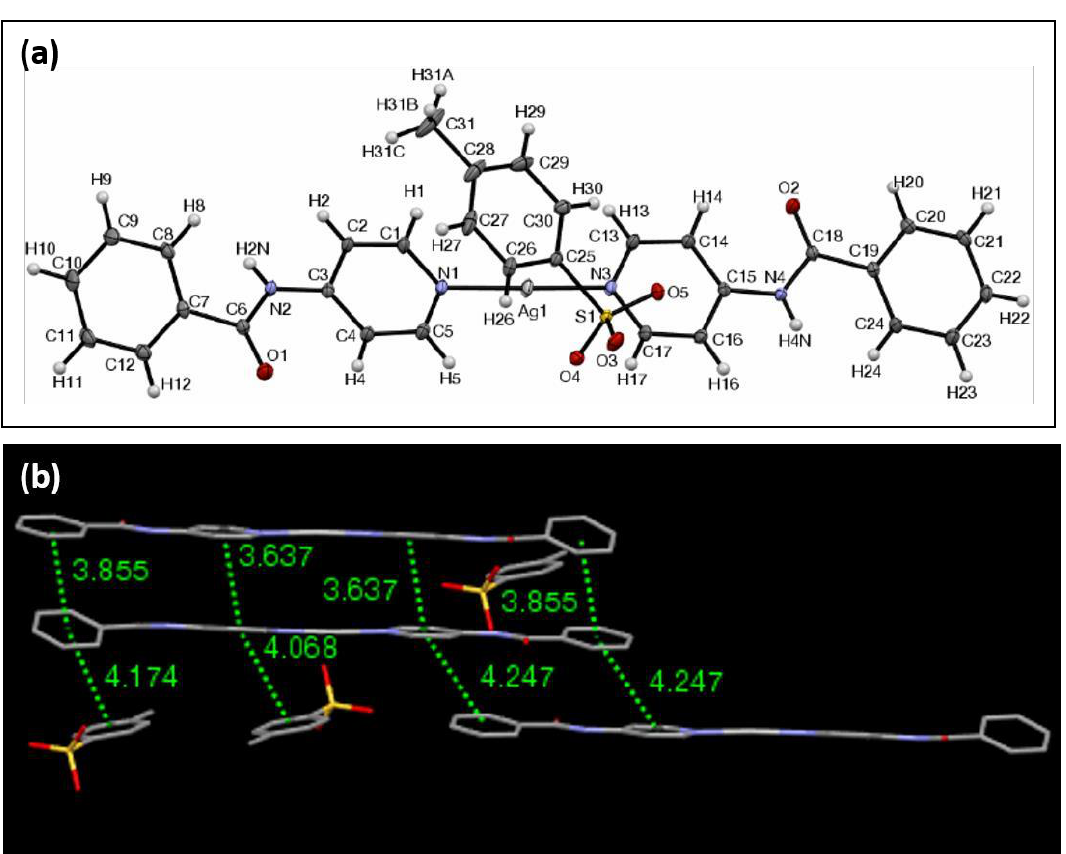
Figure 7. ( a ) The ORTEP view of complex 6 , with ellipsoids drawn at 30% probability. ( b ) The view according to π–π interaction network complex 6 , highlighting the centroid-to-centroid distances of 4.25 Å or less.